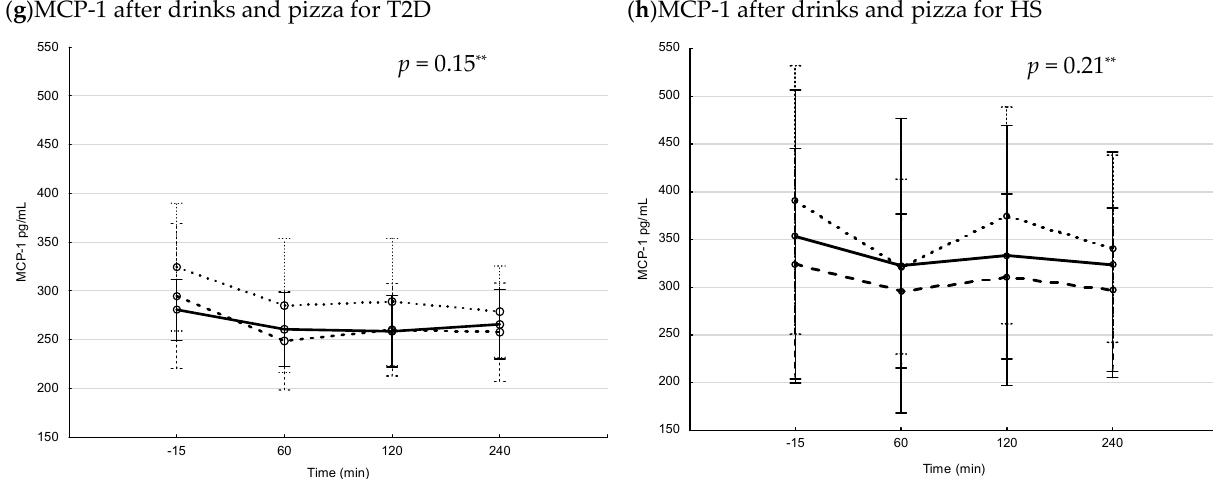
Figure A1. Postprandial serum IL-6 and MCP-1 levels in patients with type 2 diabetes (T2D) and healthy subjects (HS) after drinks and drinks + pizza. Mean values with 95% confidence interval. The S-IL-6 ( a – d ) and MCP-1 ( e – h ) levels after interventions with drinks and drinks + pizza in subjects with T2D and HS. Solid line = blueberry drink, dashed line = Coca- Cola, dotted line = fructose drink. p -values changes in interventions over time (Repeated measure ANOVA). ** = significant differences between interventions (Repeated measure ANOVA, when interaction term for Time × Intervention was found insignificant).